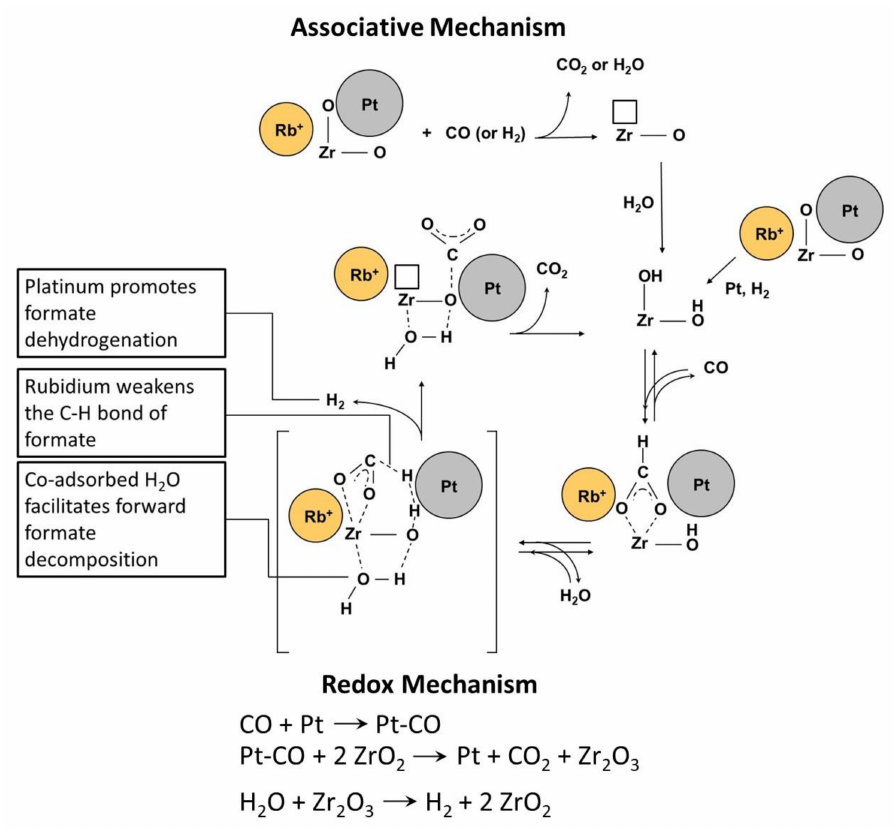
Figure 1. ( Top ) Reactant-promoted associative mechanism involving formates and carbonates; and ( Bottom ) Support-mediated redox